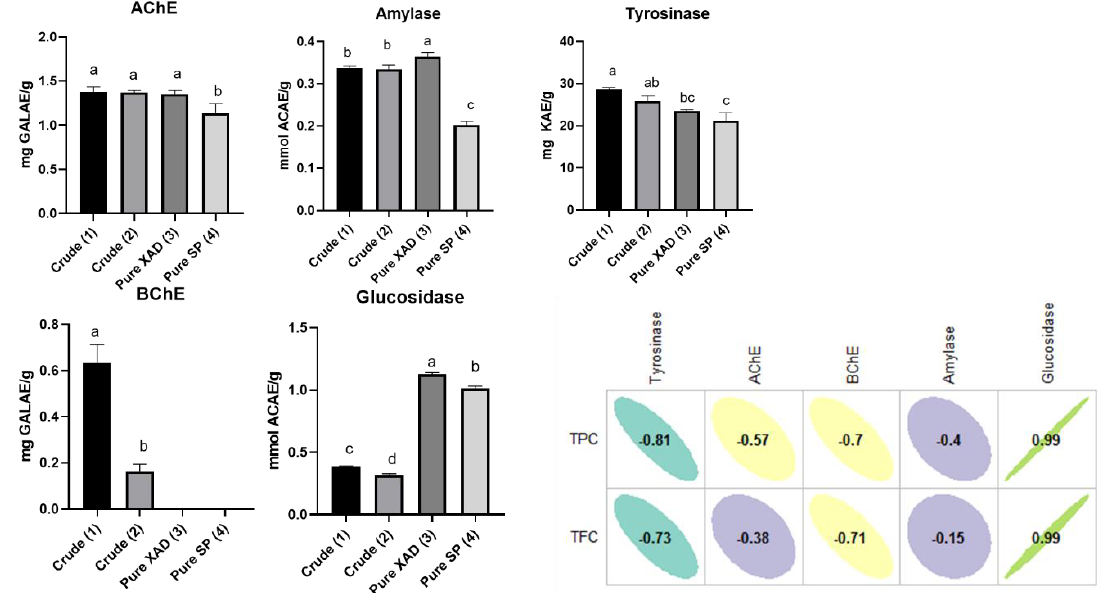
Figure 2. Enzyme inhibitory properties and Pearson’s correlation between total bioactive compounds and enzyme inhibitory properties. Values expressed are means ± S.D. of three parallel measurements. GALAE: Galatamine equivalent; KAE: Kojic acid equivalent; ACAE: Acarbose equivalent. Ni: no inhibition. Different letters indicate significant differences in the extracts ( p < 0.05).